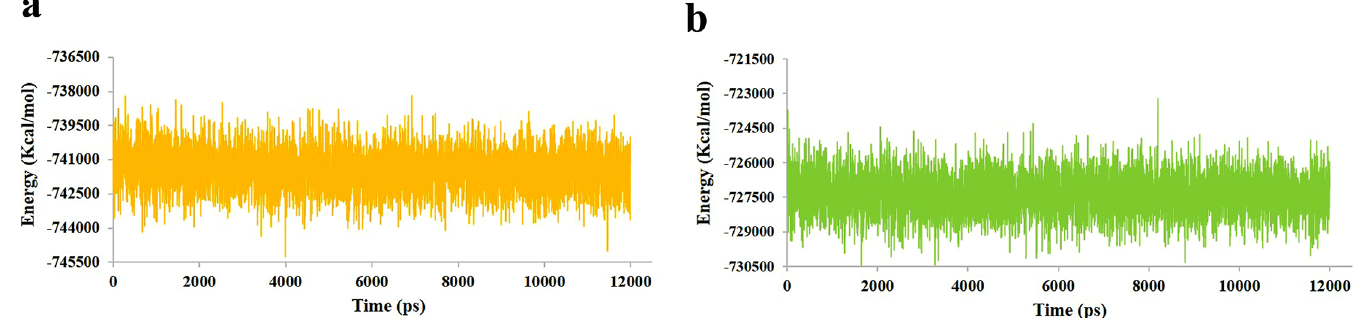
Fig 9. Energy plot for 12 ns MD simulation. (a) Energy plot for HDAC2-C8 complex (yellow). (b) Energy plot for HDAC8-C8 complex (green).